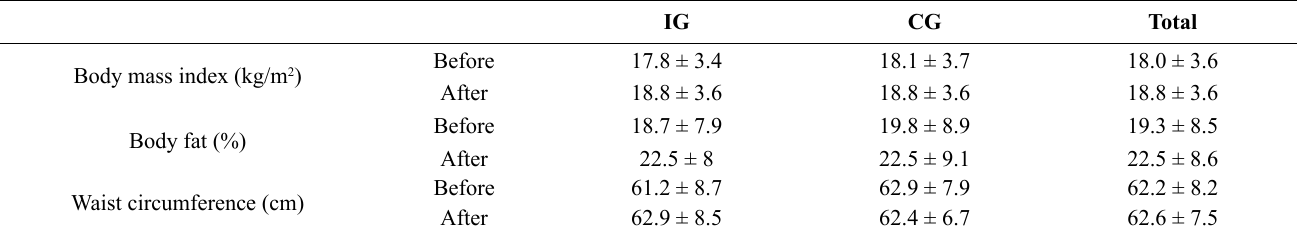
Table 3. Anthropometric variables (M ± SD) recorded before and after a 12-week, extracurricular, moderate-intensity training (MIT) or high- intensity interval training (HIIT) program.